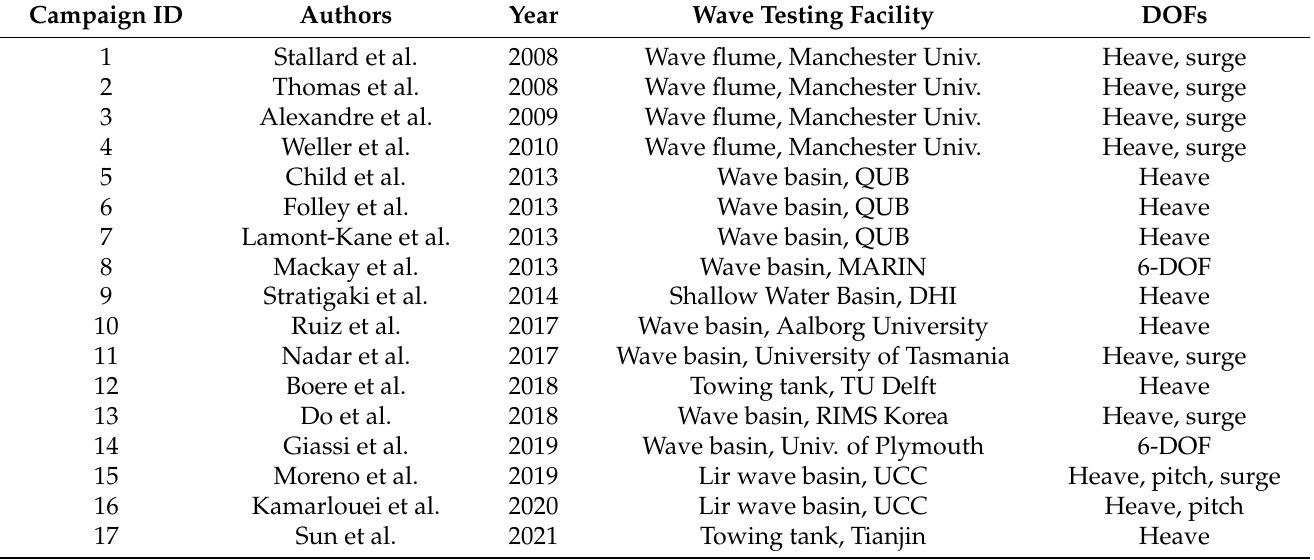
Table 1. Overview of WEC array experimental campaigns with point-absorber WECs available in the